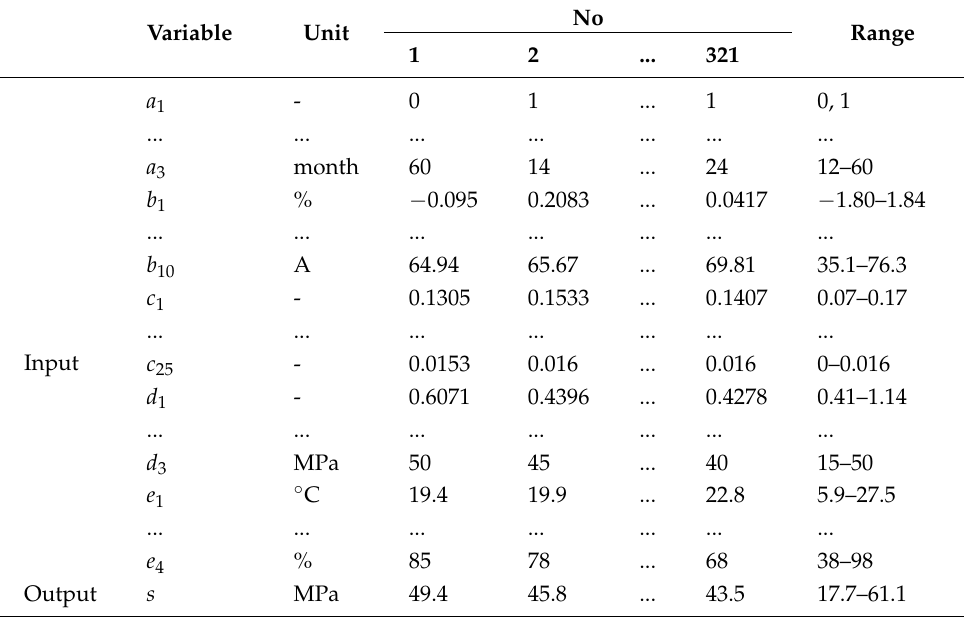
Table 2. A brief illustration of the collected input data from the five engineering aspects and the